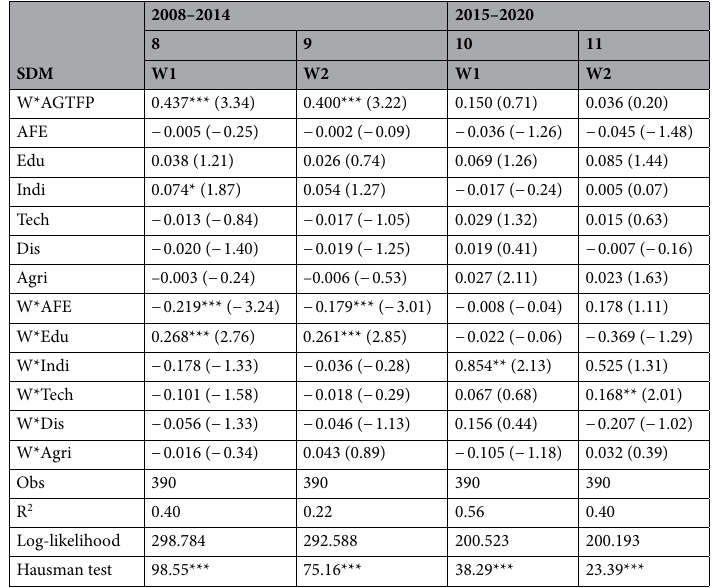
Table 6. Time classification regression. *, **, *** indicate significance at the 10%, 5% and 1% level. For the estimated coefficients, the standard errors are in parentheses.